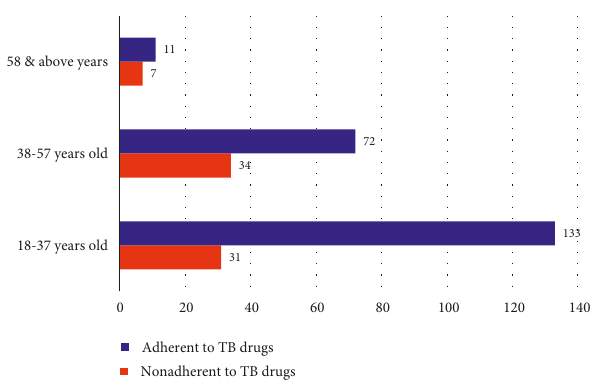
Figure 1: Patients age category versus TB-drug adherence